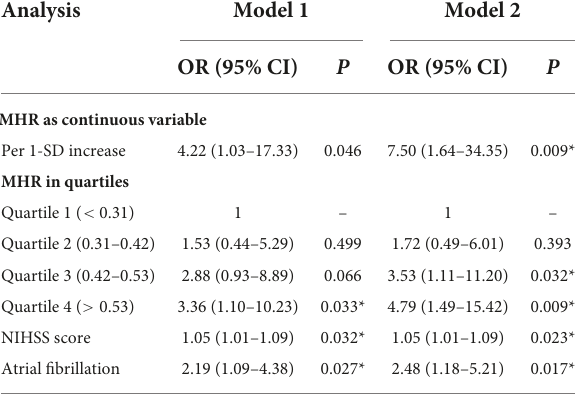
FIGURE2 Receiver operating characteristic curve to assess the relationship between monocyte to high-density lipoprotein ratio (MHR) and hemorrhagic transformation (HT). AIS, acute ischemic stroke; HT, hemorrhagic transformation; MHR, monocyte to high-density lipoprotein ratio.